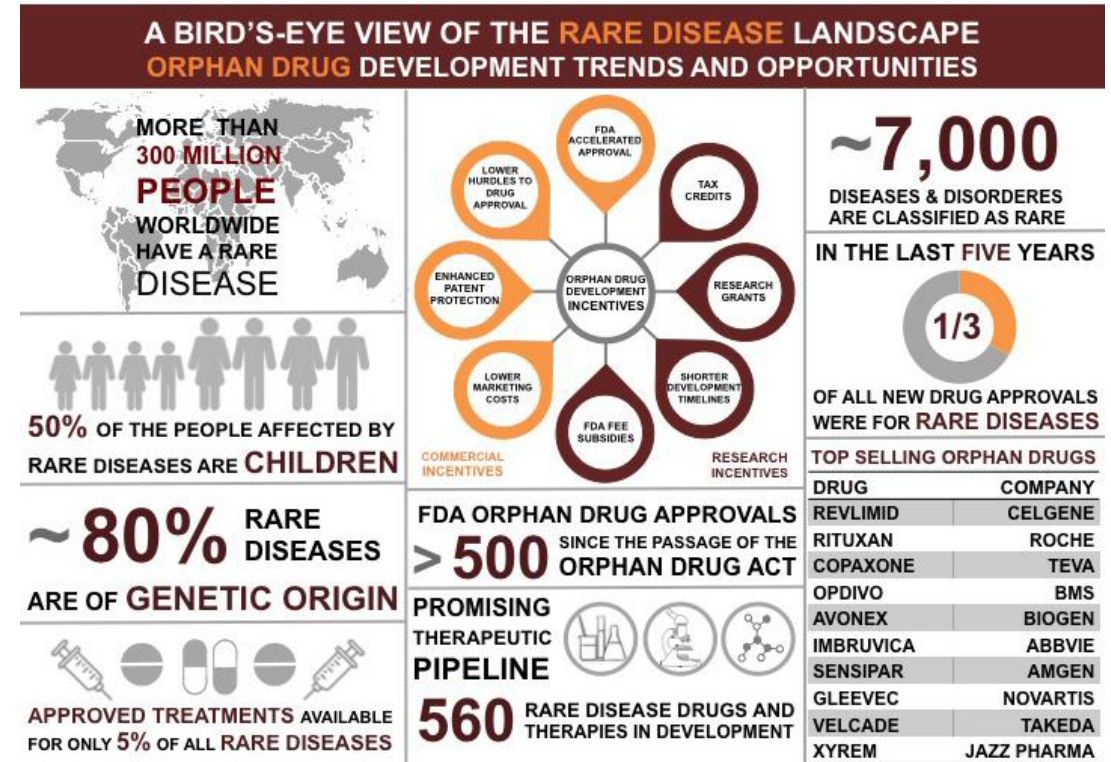
Figure 1. Opportunities and Challenges in developing orphan drugs to prevent, diagnose and treat rare